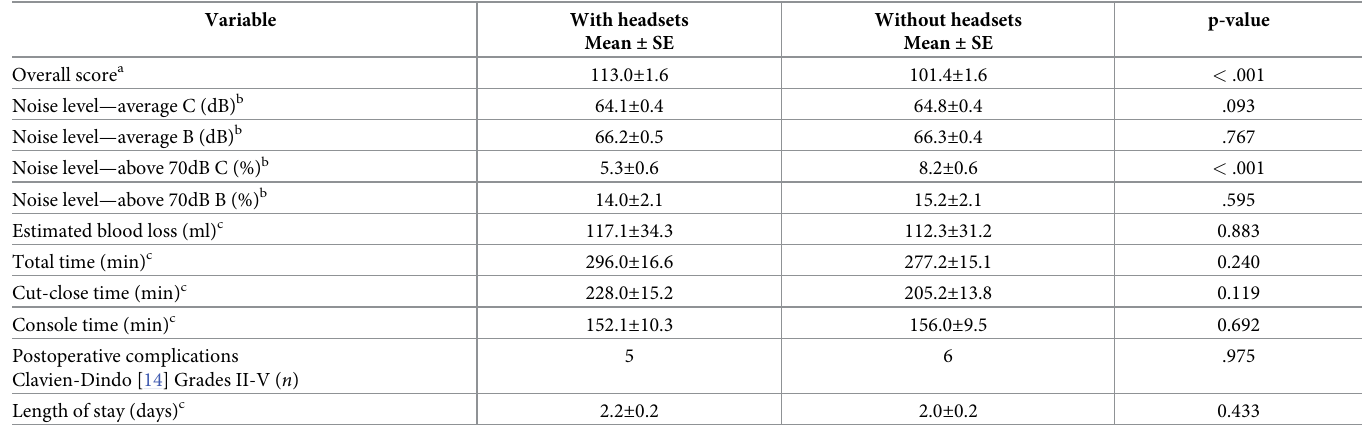
Table 4. Outcomes comparison by use of